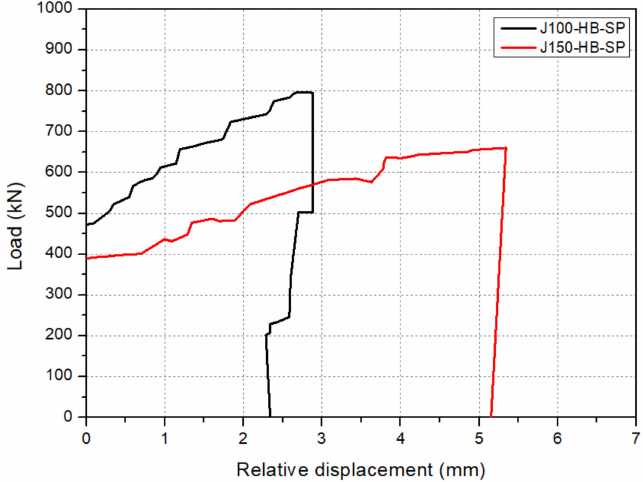
Figure 5. Load–relative displacement curves according to joint